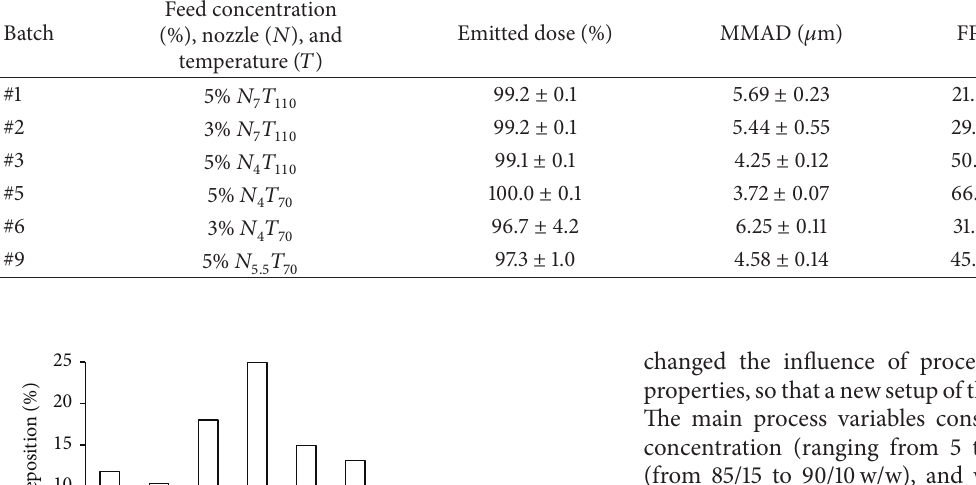
Table 2: Aerodynamic properties of nanospray-dried Klys/leu (15% leu, 30% IPA) powders after ACI experiments: emitted dose (ED), mass median aerodynamic diameter (MMAD), fine particles fraction (FPF), and fine particle dose (FPD). Batch